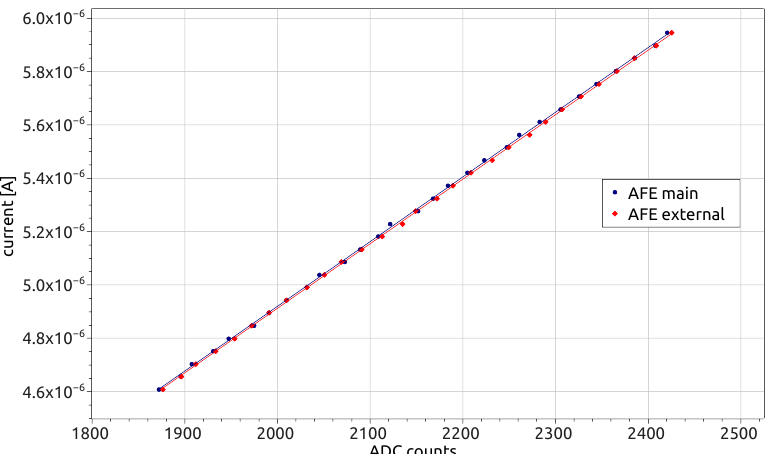
Figure 20. Main and external AFE ammeter calibration. The scale is limited to a narrow range to show small differences in presented values.